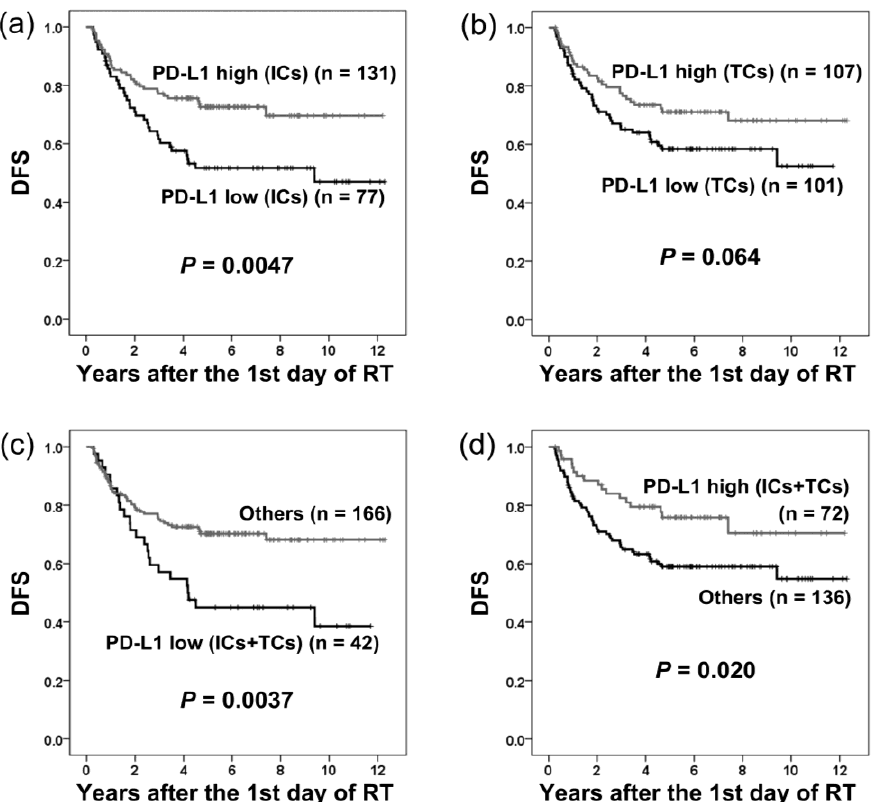
Figure 4. Disease-free survival (DFS) in patients with different levels of PD-L1 expression on immune cells (ICs) and tumor cells (TCs). Low PD-L1 expression on ICs ( a ) or both ICs and TCs ( c ) was associated with shorter DFS. PD-L1 expression on TCs ( b ) had no significant influence on DFS. High PD-L1 expression on both ICs and TCs ( d ) correlated with longer DFS.